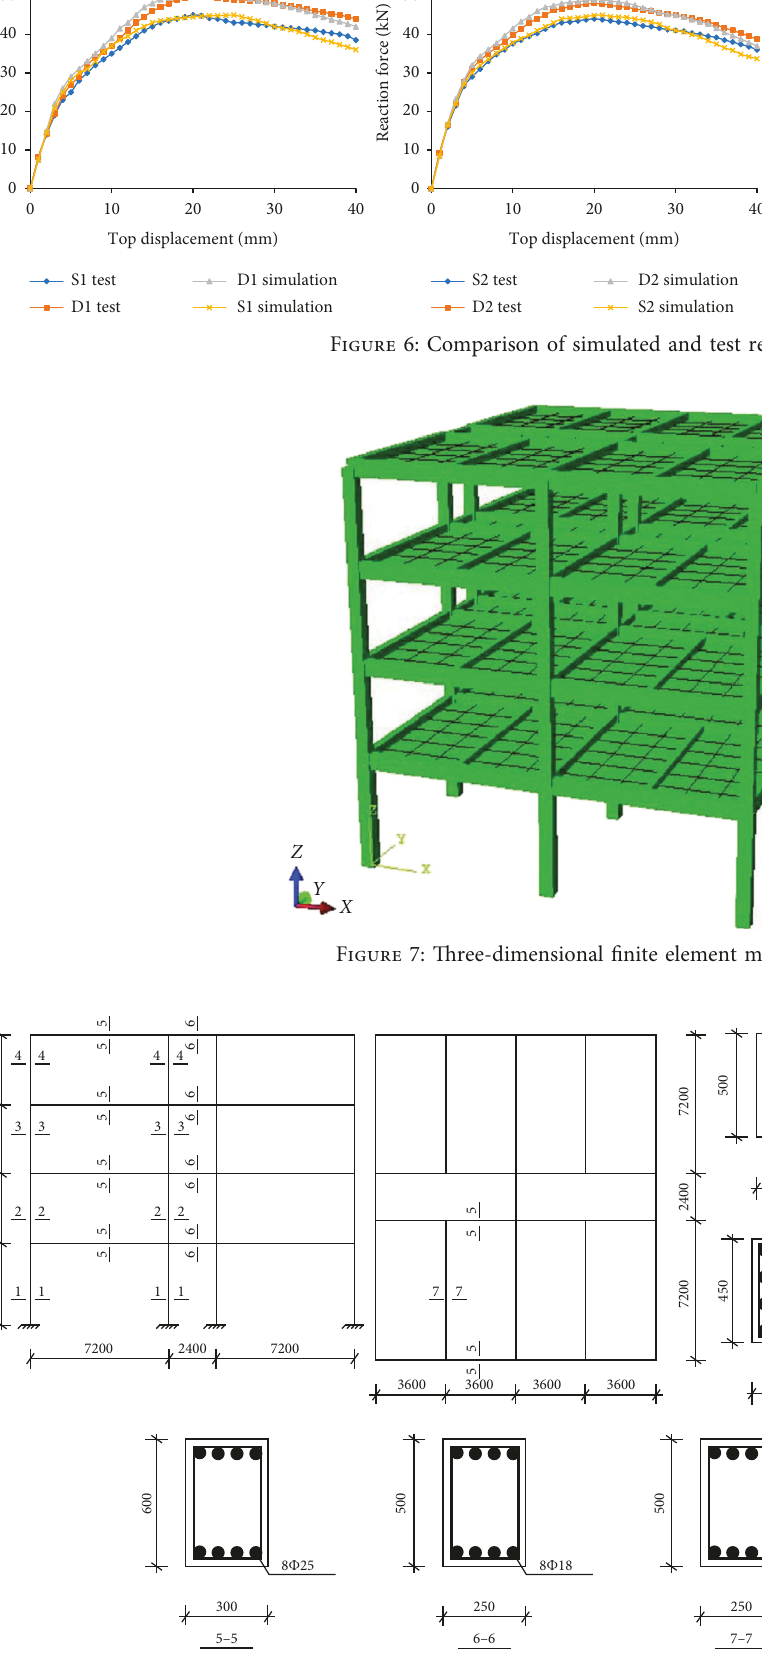
Figure 8: Dimensions and bar arrangement (unit: